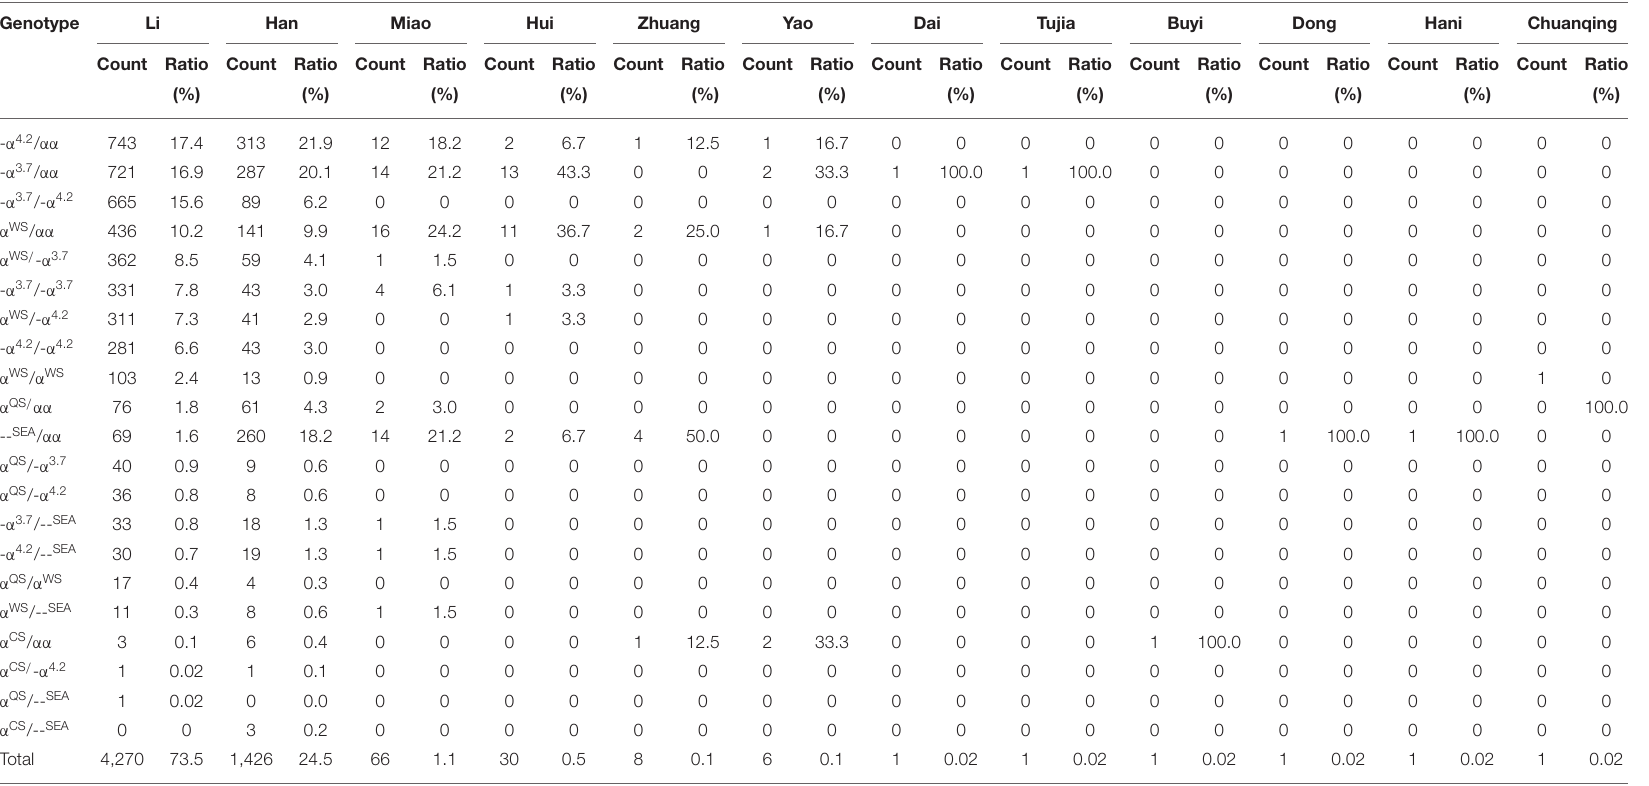
TABLE 6 | Distribution of α -thalassemia genotypes in the Han people and ethnic minorities in the southern area of Hainan. Genotype Li Han Miao Hui Zhuang Yao Dai Tujia Buyi Dong Hani Chuanqing Count Ratio Count Ratio Count Ratio Count Ratio Count Ratio Count Ratio Count Ratio Count Ratio Count Ratio Count Ratio Count Ratio Count Ratio (%) (%) (%) - α 4.2 / αα - α 3.7 / αα - α 3.7 /- α 4.2 α WS / αα 436 10.2 0 α WS / - α 3.7 362 - α 3.7 /- α 3.7 0 α WS /- α